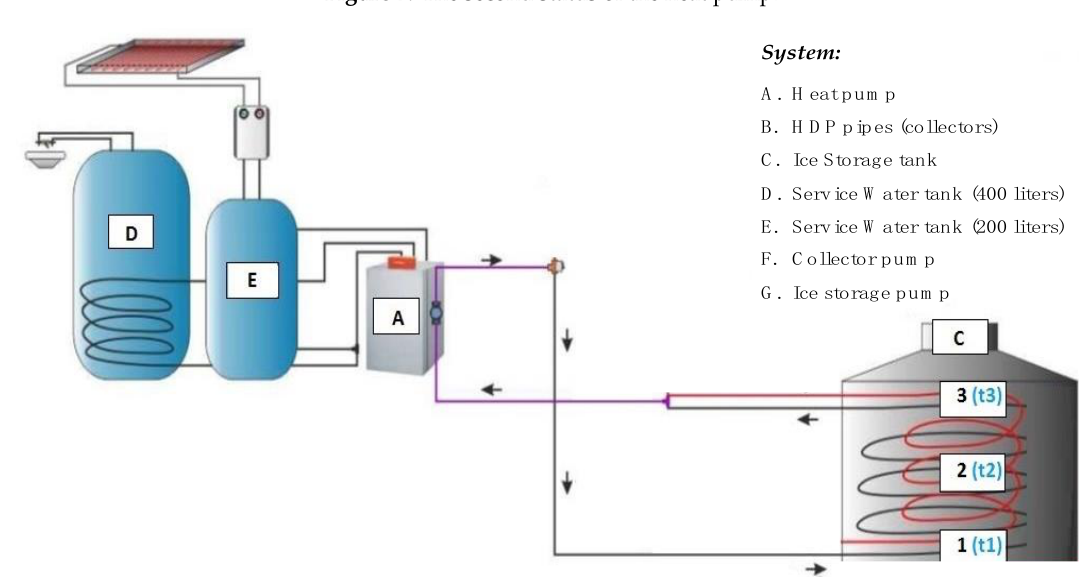
Figure 8. The third status of the heat pump.